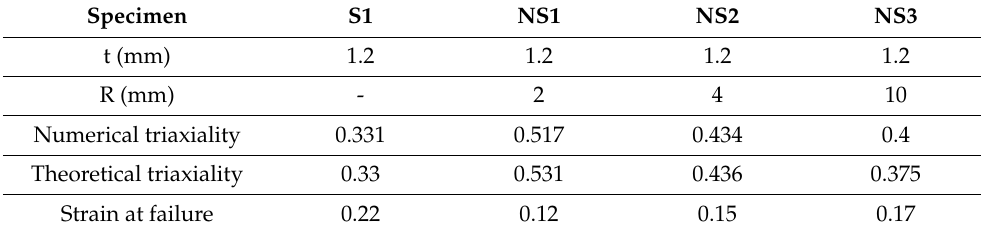
Table 3. Comparison between theoretical and numerical triaxiality for DC01 material. Specimen S1 Specimen